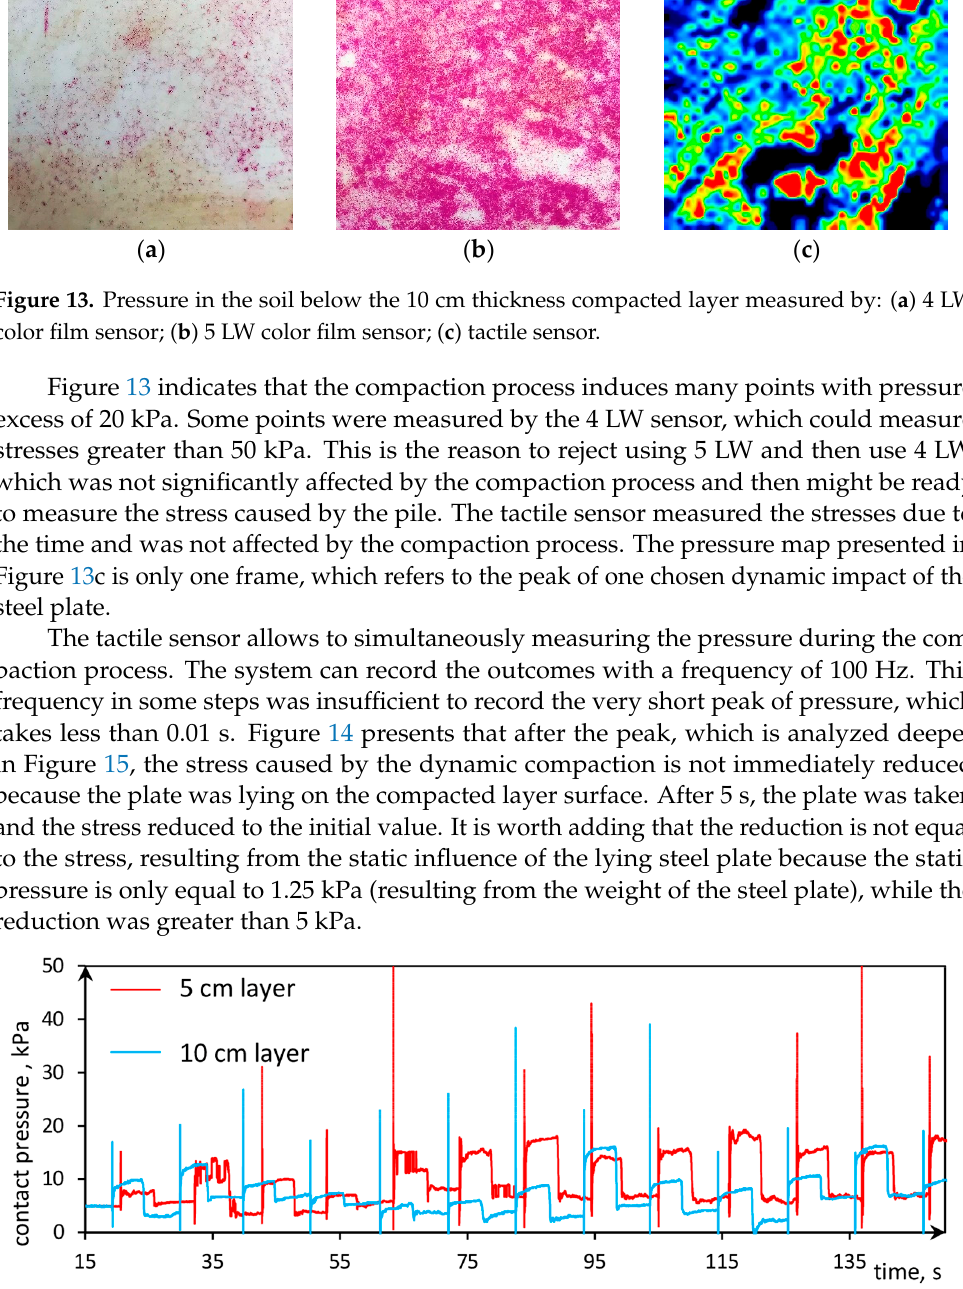
(3) where: 𝑔 —gravity acceleration, which equals 9.81 m/s 2 ; ℎ —plate drop height, which equals 0.05 m; 𝑚 —the weight of steel plate, which equals 14.4 kg; 𝐸 (cid:2868) —elasticity modulus of soil in the range 540–1200 Pa, 𝑡 —thickness of soil layer, which equals 0.05 or 0.10 m; 𝐴 —area of the plate, which equals 0.118 m 2 . Two effects might explain the irregular behavior of the measured contact pressures. First, the initial contact area in every compaction step was not the same due to the decli- nation of the plate to the soil surface. Second, the stress that was induced during compac- tion of the 5 cm soil layer was higher than the observed in compaction of the 10 cm layer, especially at the beginning of compaction, because of the stiffness of soil, which increased faster in the case of a thin layer.